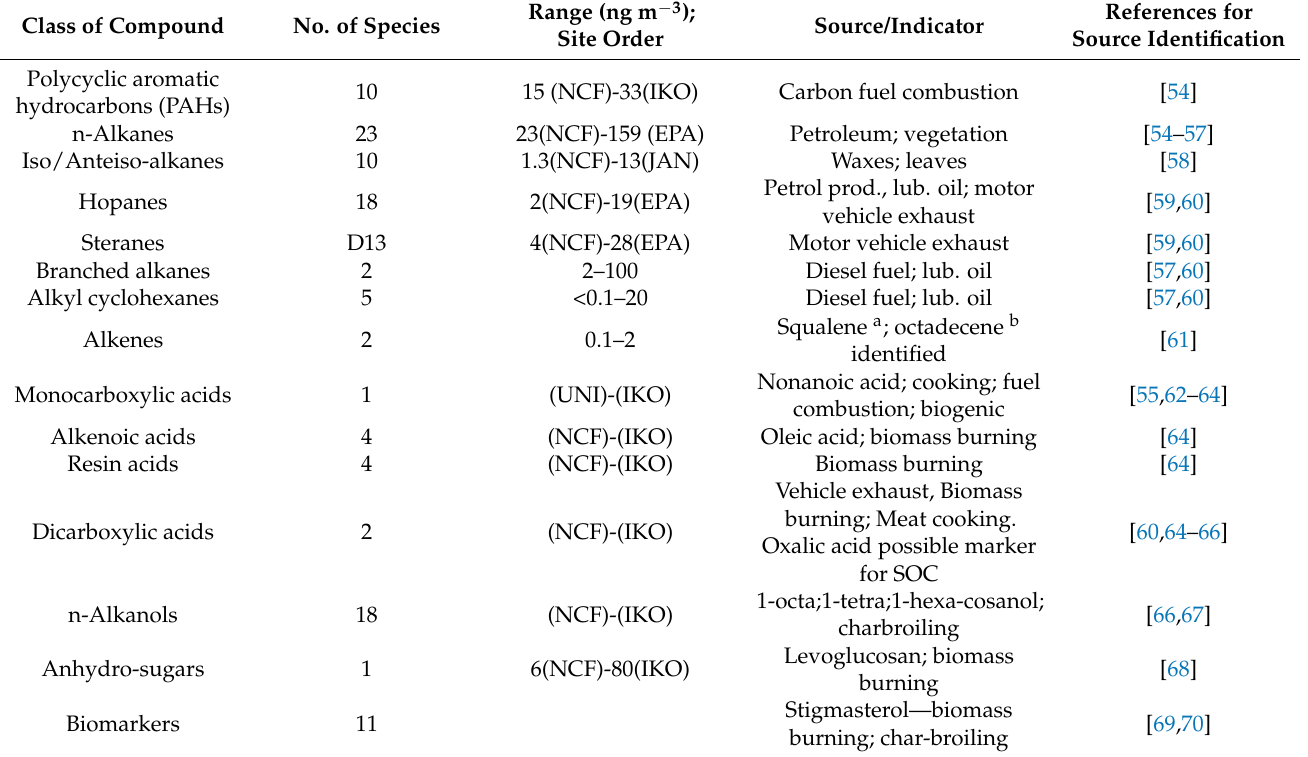
Table 4. Categories of organic species observed by GC-MS analysis in Lagos PM 2.5